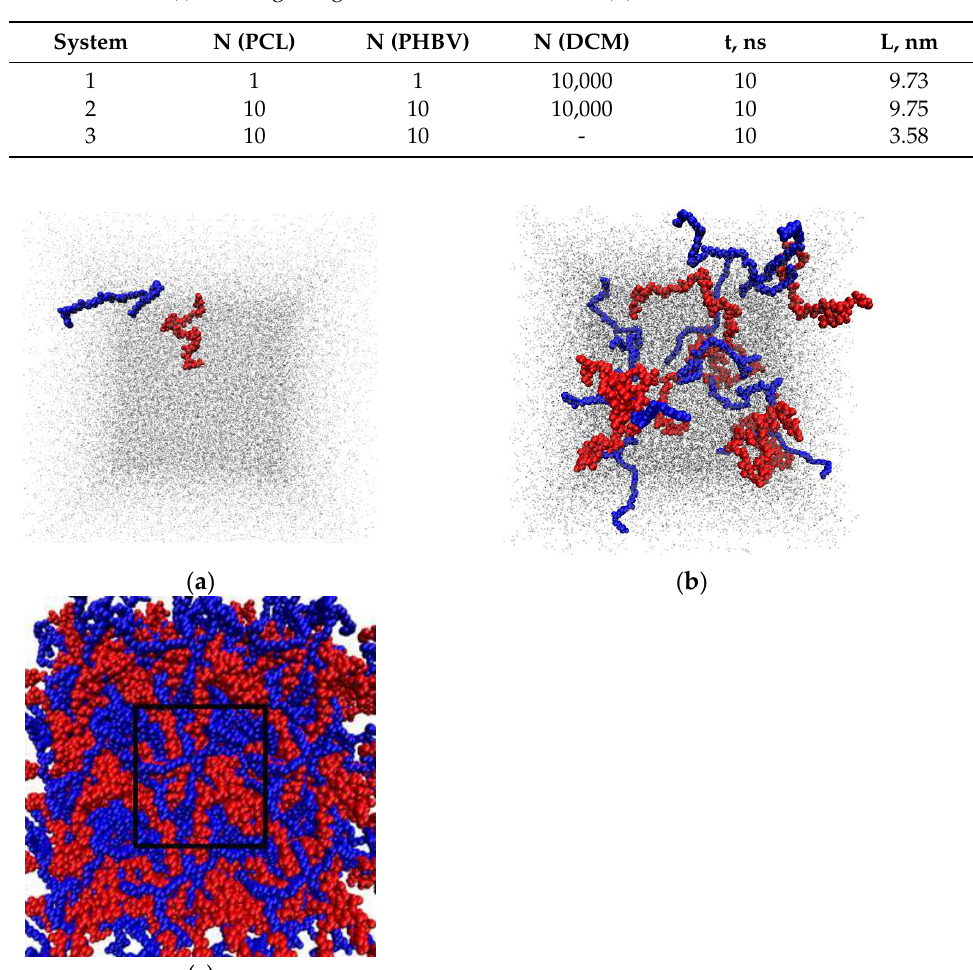
Table 7. Simulation details of the systems: number of molecules, macromolecules or particles (N), simulation time (t), and edge length of the simulation boxes (L).